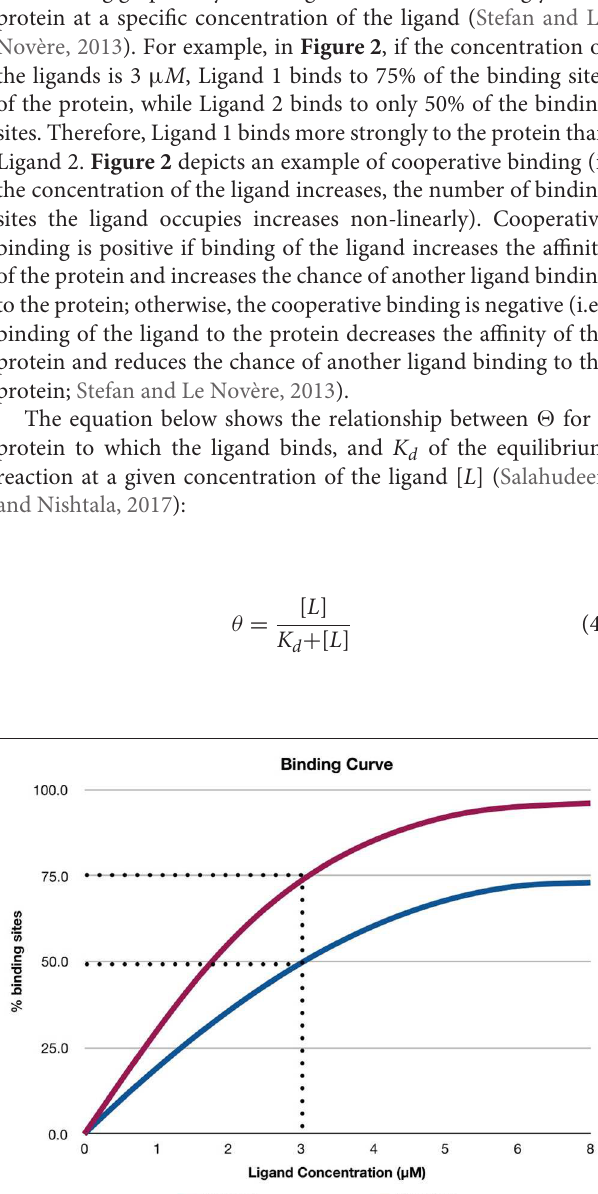
Frontiers in Chemistry |